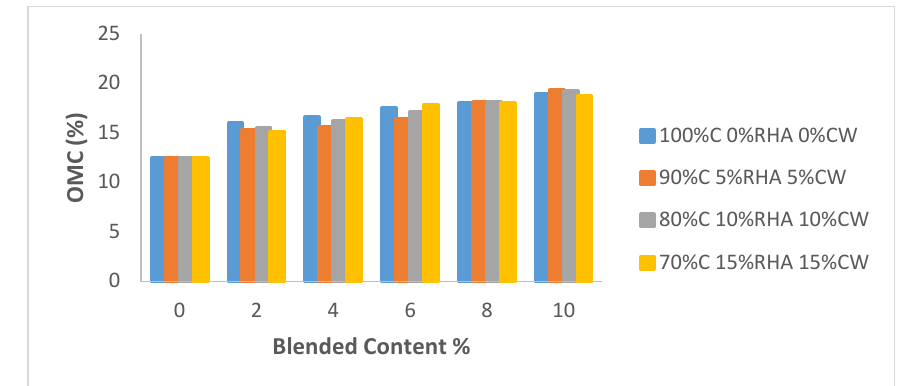
Fig. 7. Relationship between the OMC of laterite treated with (100%C 0%RHA 0%CW), (